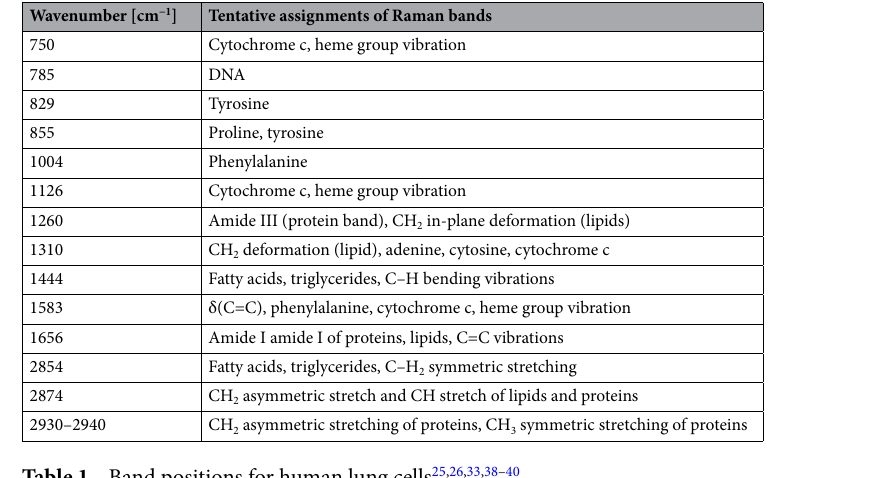
Table 1. Band positions for human lung cells 25,26,33,38–40